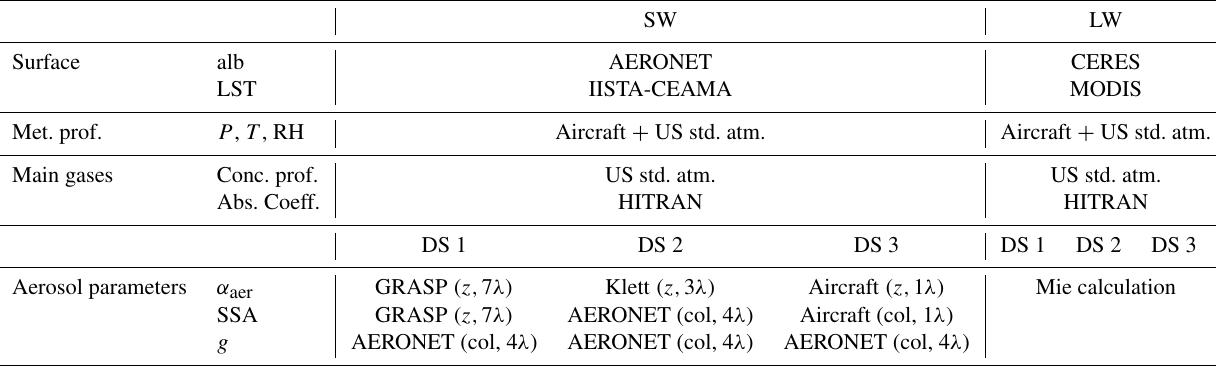
Table 2. Summary of the data sources used to obtain the input data parameterizations for GAME computations both in the SW and LW spectral ranges, including the surface parameters (albedo, alb, and land-surface temperature, LST), profiles of meteorological variables, and main gases and the aerosol parameters. For the aerosol parameters (aerosol extinction, α aer ; single scattering albedo, SSA; and asymmetry parameter, g ) three different datasets are used (DS1, DS2, and DS3) based on different instrumentation and retrievals. The indications below the sources of the aerosol parameters indicate whether the parameter is column-integrated (col) or if it is vertically resolved ( z ) and the number of wavelengths at which it is given ( nλ ). SW LW Surface alb AERONET CERES LST IISTA-CEAMA MODIS Met. prof. P , T , RH Aircraft + US std. atm. Aircraft + US std. atm. Main gases Conc. prof. US std. atm. US std. atm.